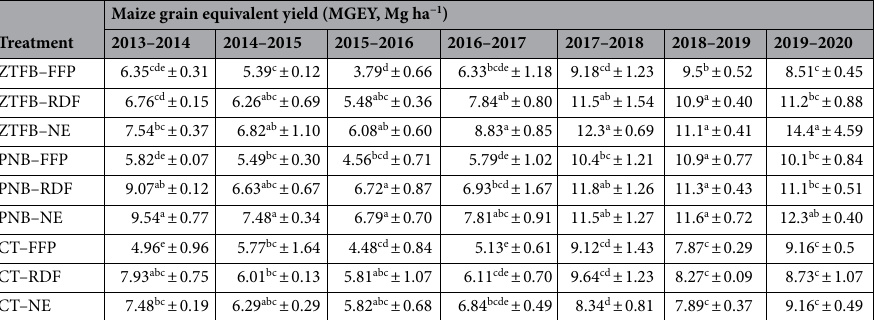
Table 2. Interaction effect of the CA-based CEP and nutrient management on the system productivity (± S.D.) in terms of MGEY during the 7 years of the study in the maize–chickpea rotation. Means followed by a similar uppercase letter within a column is not significantly different (p < 0.05) according to Tukey’s HSD test.